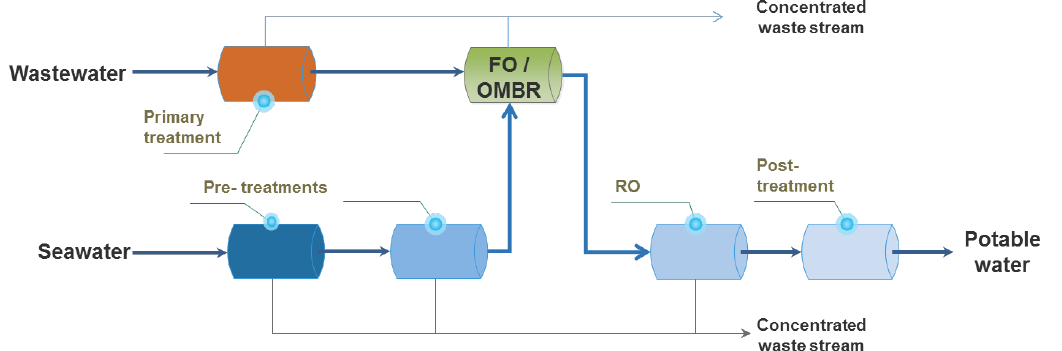
Figure 4. Schematic of use of FO as a standalone process or together with a secondary (biological) treatment (OMBR).